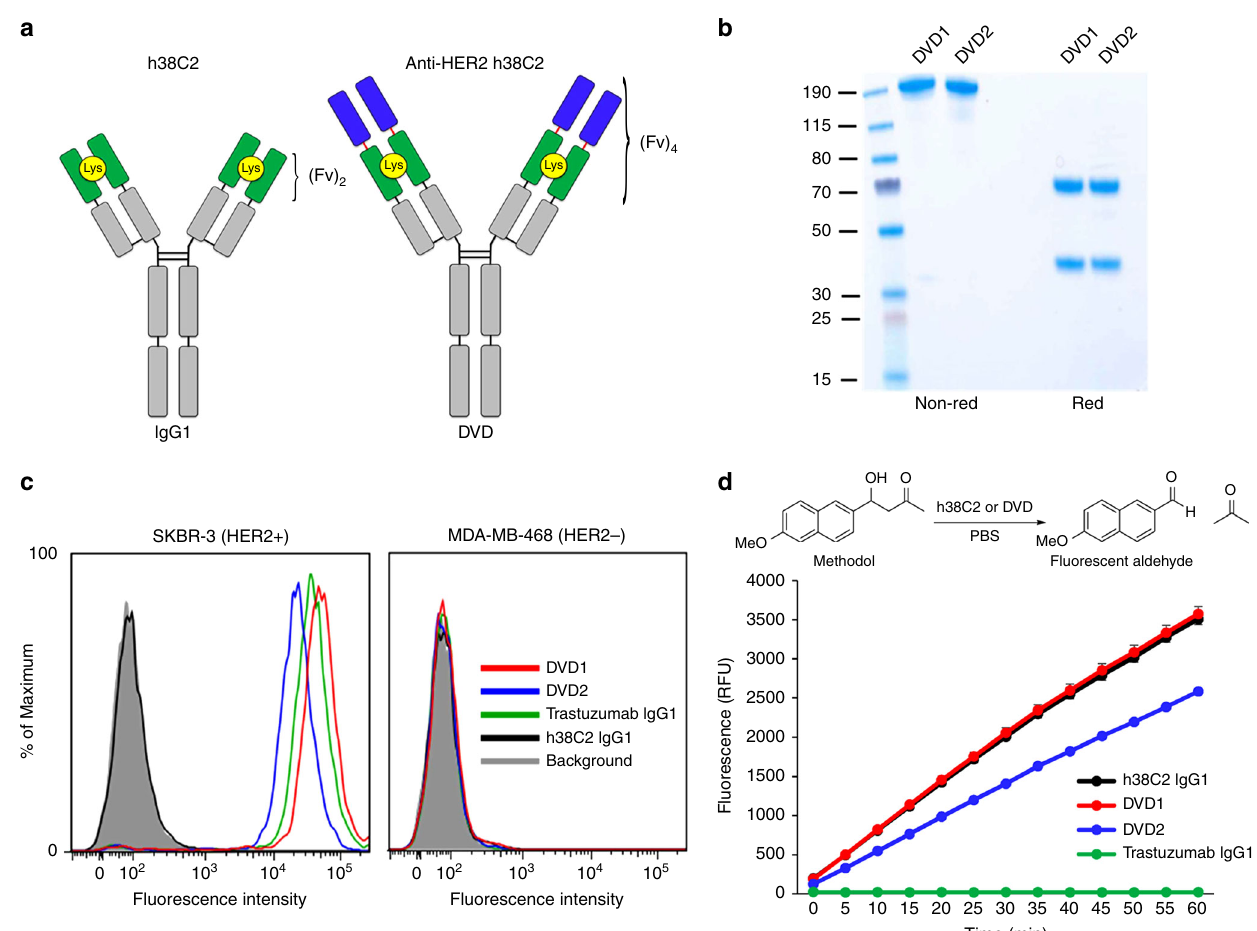
Fig. 1 Construction of anti-HER2 DVDs. a h38C2 IgG1 compared to an anti-HER2 DVD. The DVD is composed of variable domains of trastuzumab (blue), h38C2 (green) with reactive Lys (yellow circle), and constant domains (gray). Two fully human spacer sequences (red lines) were used to prepare DVD1 with a short spacer (ASTKGP) or DVD2 with a long spacer (TVAAPSVFIFPP). b Coomassie stained SDS-PAGE con fi rmed the purity of both DVD1 and DVD2 under non-reducing (expected ~200 kDa) and reducing conditions (expected heavy chain ~63 kDa, light chain ~36 kDa). Molecular weights from a pre-stained protein ladder are shown on the left. c Flow cytometry showing speci fi c binding of DVD1 (red) and DVD2 (blue) to SK-BR-3 cells (HER2+) with no binding detected to MDA-MB-468 cells (HER2 − ). Trastuzumab IgG1 (green) was used as a positive control and h38C2 IgG1 (black) as a negative control. d The catalytic retro-aldol activity of the reactive Lys of h38C2 was measured using methodol as a substrate. The signal is reported in relative fl uorescent units (RFU; mean ± SD of triplicates). Trastuzumab IgG1 (green) was used as a negative control. The slope of DVD1 was not signi fi cantly different ( p = 0.1967; linear regression analysis) from h38C2 IgG1, but the slope of DVD2 was signi fi cantly smaller ( p <